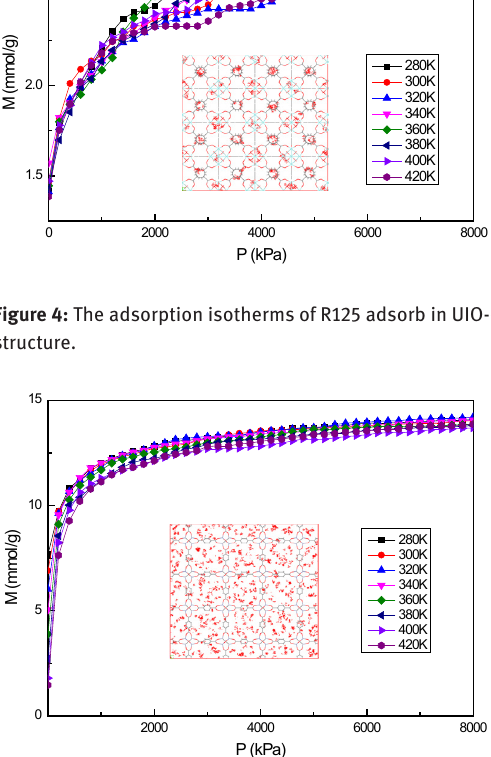
Figure 5: The adsorption isotherms of R125 adsorb in MOF-5